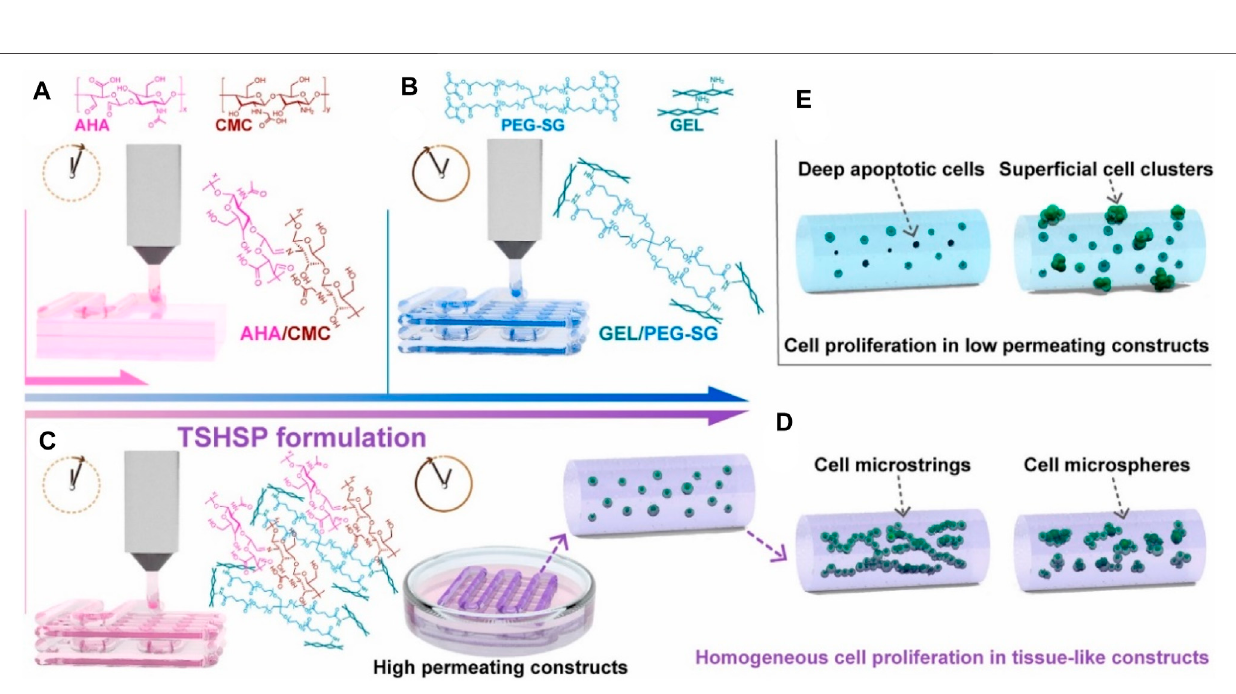
Frontiers in Bioengineering and Biotechnology |